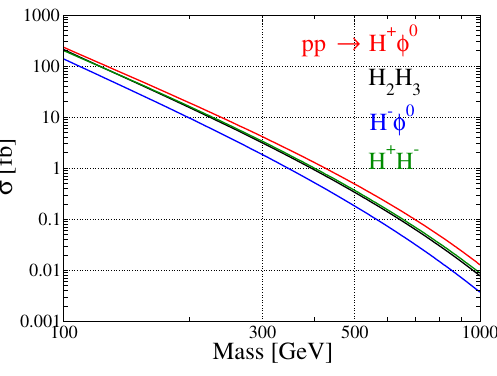
p s = 13 TeV with m